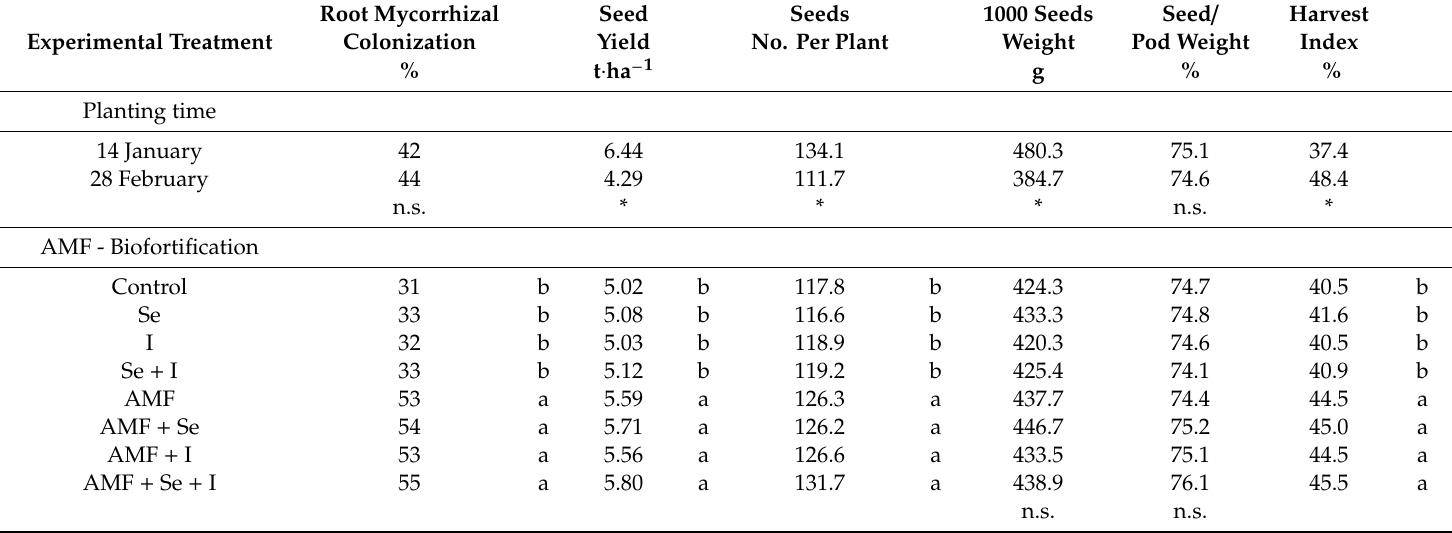
131.7 76.1 45.5 a n.s.